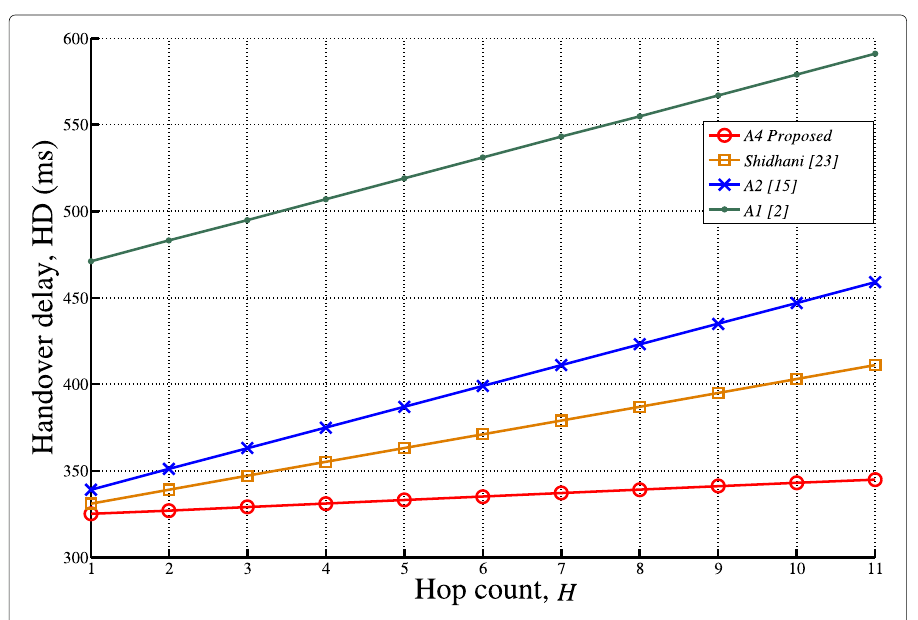
Fig. 17 Handover delay with hop count (WiMAX-WLAN)